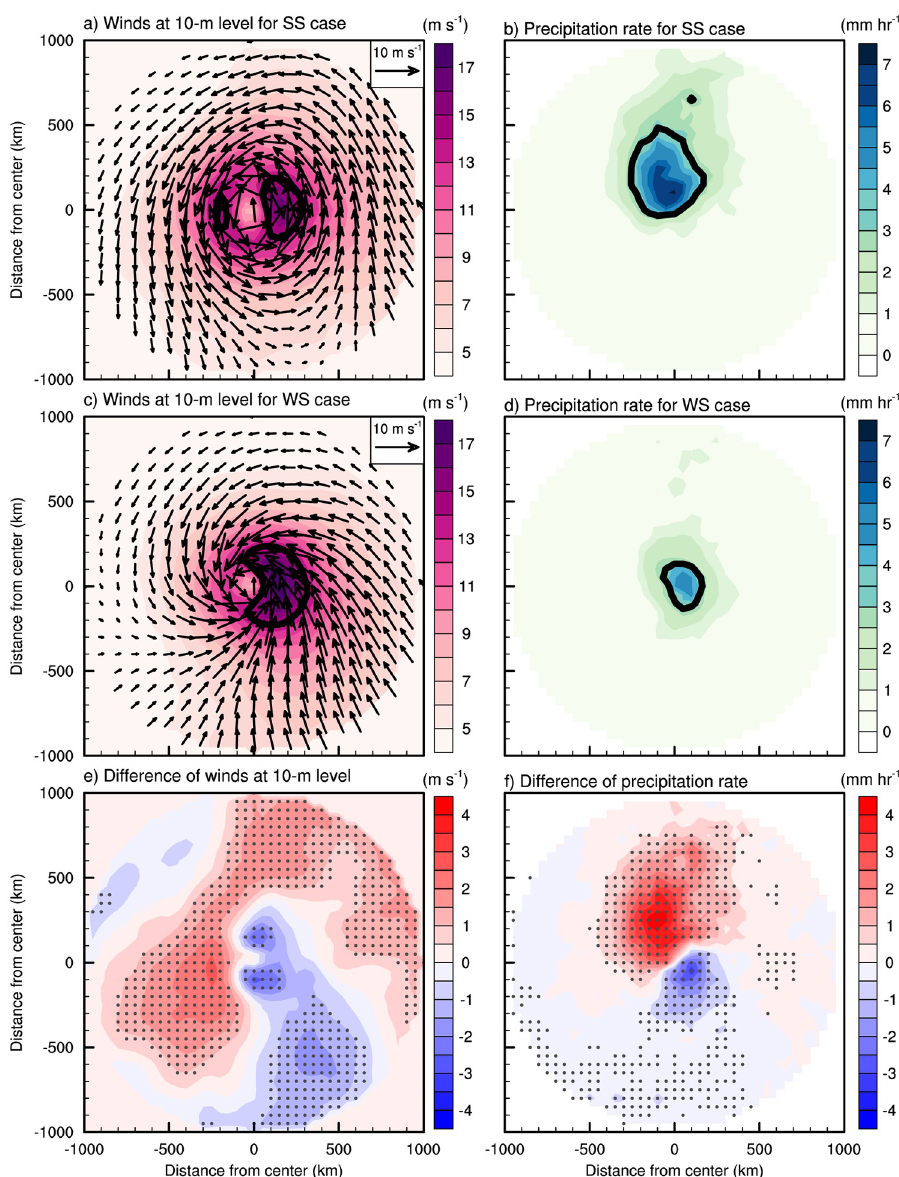
Fig 7. The averaged horizontal TC structure of wind at 10-m level (arrows, unit: m s -1 ) with its speed (shaded, unit: m s -1 ), and precipitation rate (unit: mm hr -1 ) for the (a, b) strong shear (SS) case, (c, d) weak shear (WS) case, and (e, f) their differences (SS minus WS) during the landfall period. The directions of x- and y- axis are right and front to TC motion, respectively. The gray dots indicate the statistically significant differences at the 95% confidence level evaluated with Student’s t